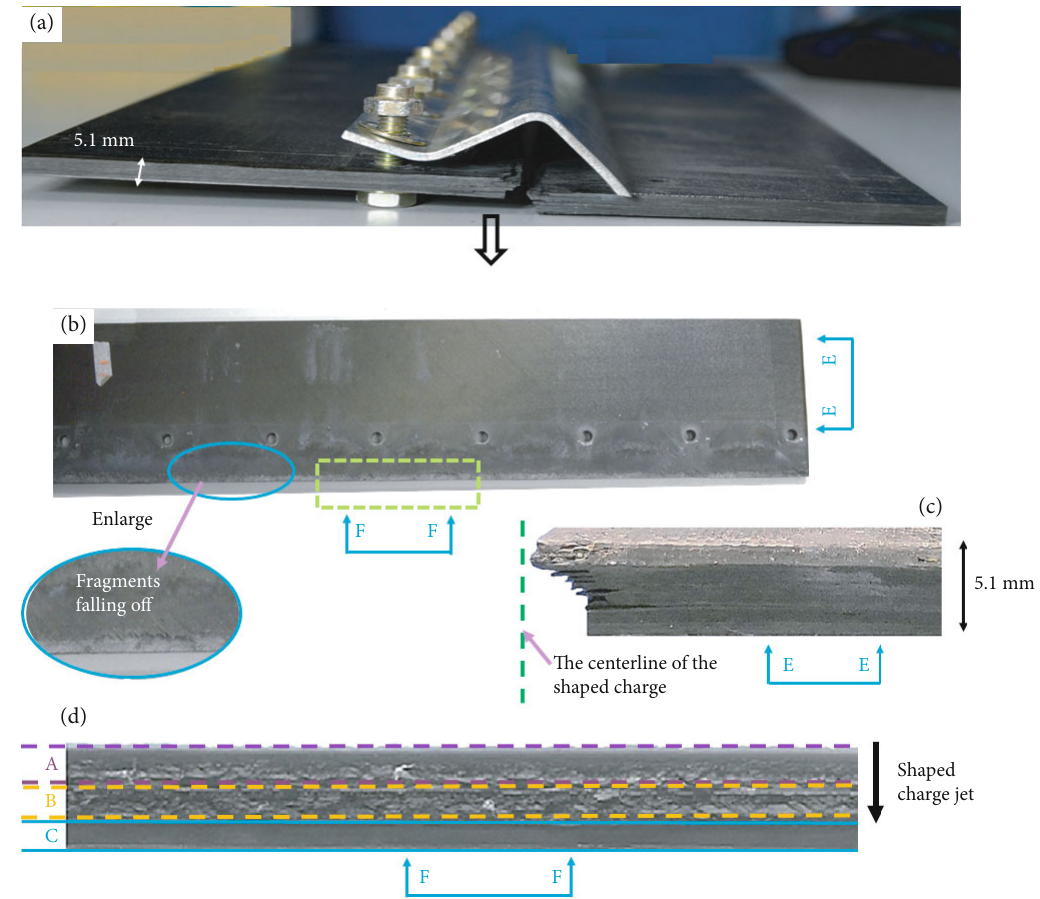
Figure 6: Macroscopic analysis. (a) Composites separation device. (b) Front view. (c) Side view. (d) Cutting